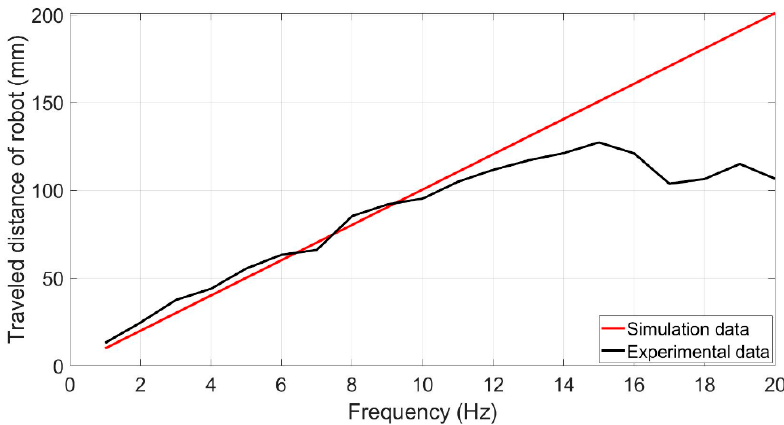
Figure 8. Comparison of experimental and simulation data .